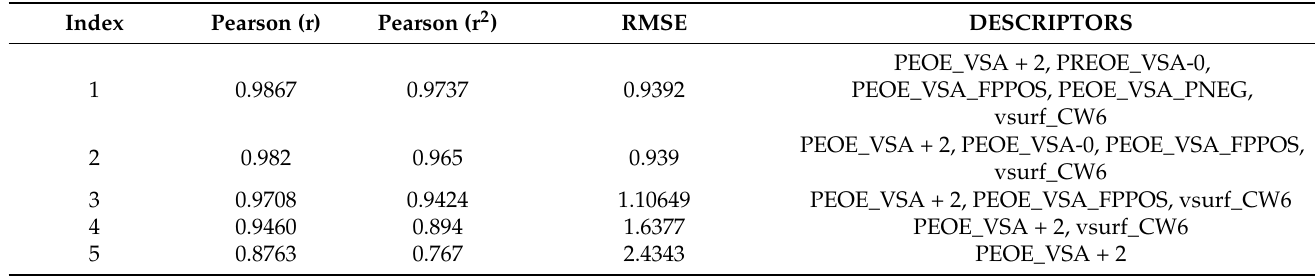
Table 4. Descriptors used in QSAR model for C. albicans